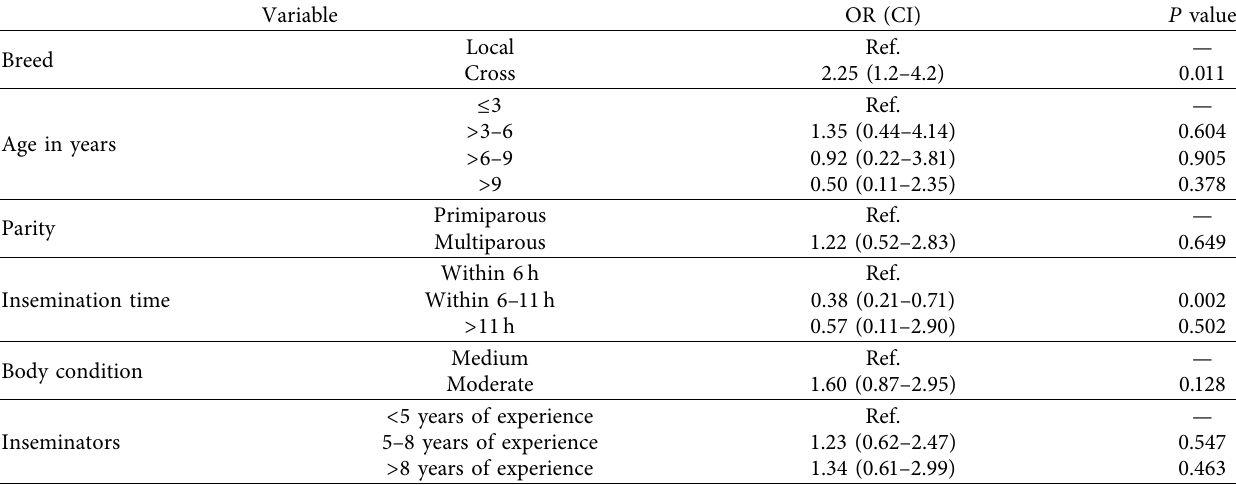
Table 2: Multiple logistic regression result showing the association of pregnancy rates with different factors.